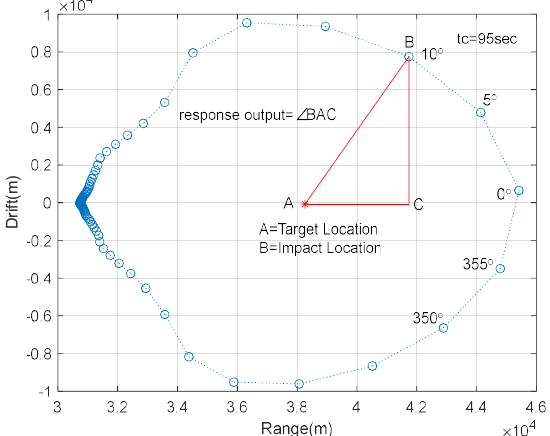
Figure 12. Footprints of Swerve Response.